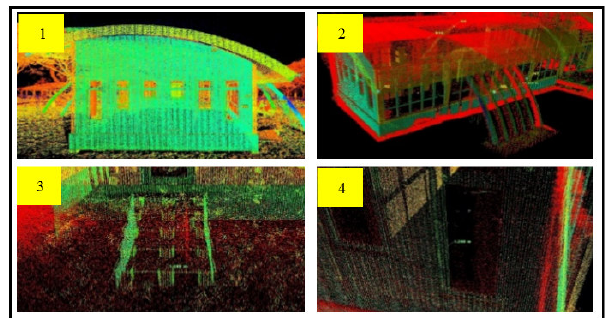
Figure 14. A part of measurement used for the comparison purpose. The 1 and 2 are measurement of dimension of floor while 3 and 4 are measurement of stairs and window size.